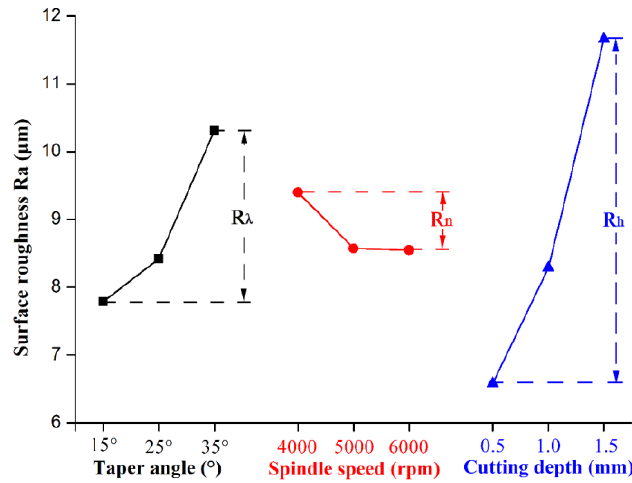
Figure 5. Cutting parameters and surface roughness trend chart.